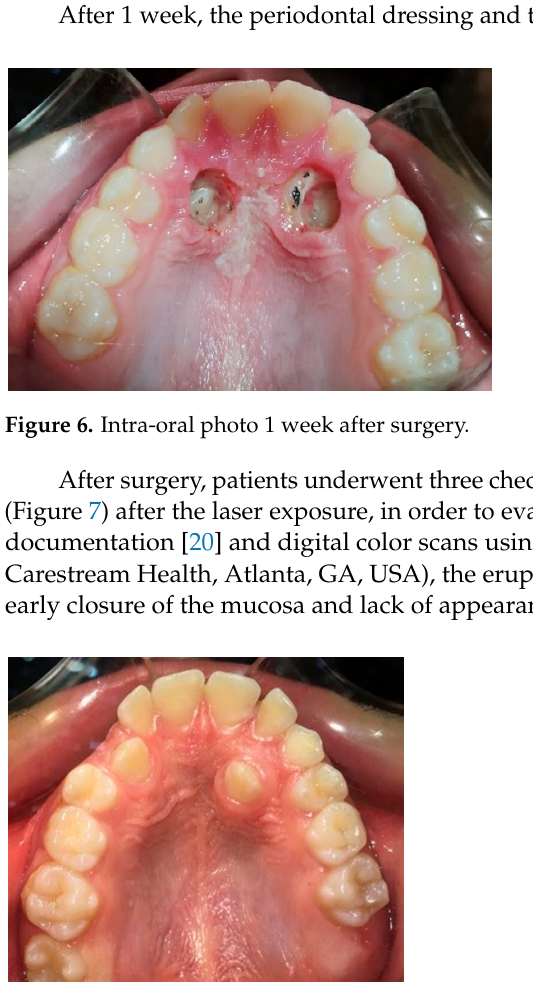
Figure 7. Intra-oral photo 16 weeks after surgery.